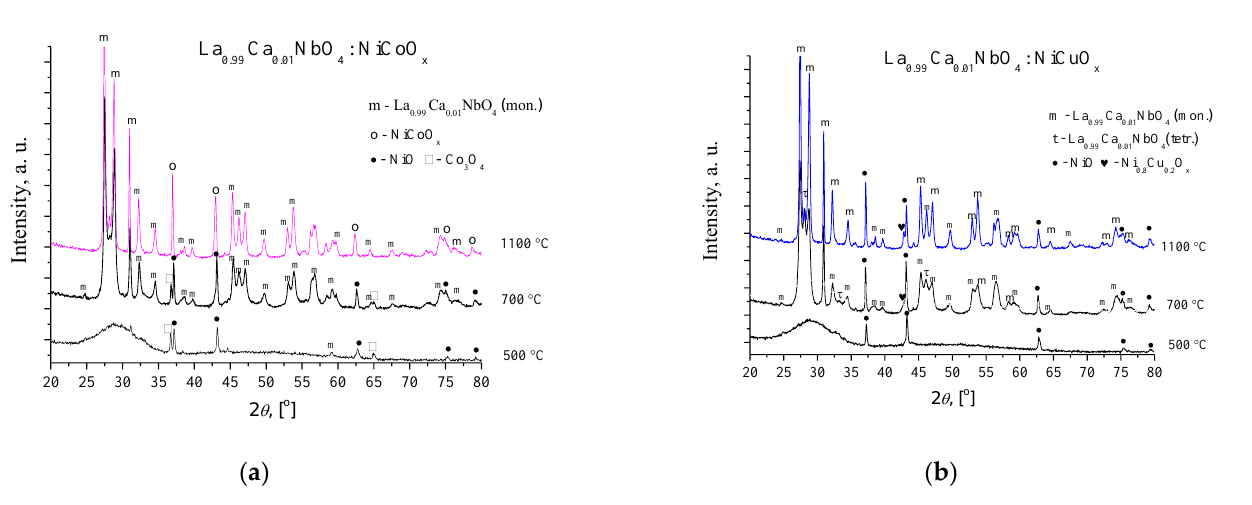
Figure 5. XRD patterns of the composites NiCo – LCNb ( a ) and NiCu – LCNb ( b ) sintered at 500 –